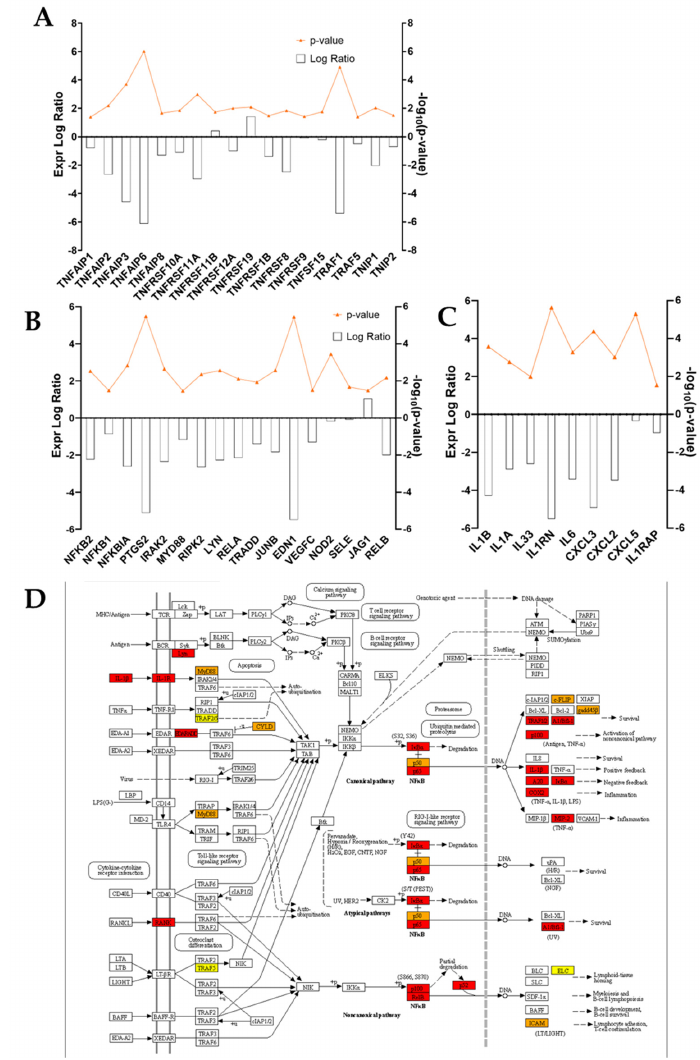
Figure 6. ( A – C ) Expression logarithmic ratios of differentially regulated genes from the w/ TNF α microarray involved in the inflammation response. Expression is displayed as a bar, while significance, expressed as − log10( p -value), is reported in orange. ( D ) KEGG pathway: IL-1b and NF-kB pathway, with color-coded protein slots corresponding to DEGs expression. Inflamed fibroblast (w/ TNF α ) RNA-seq output was further analyzed with Ingenuity Pathway Analysis (IPA) software. The IPA gene ontology algorithm classifies canonical pathways based on their statistical relevance ( p -value) and activation status (z-Score) by identifying each DEG’s role in specific biological pathways. Among the ten higher ranking